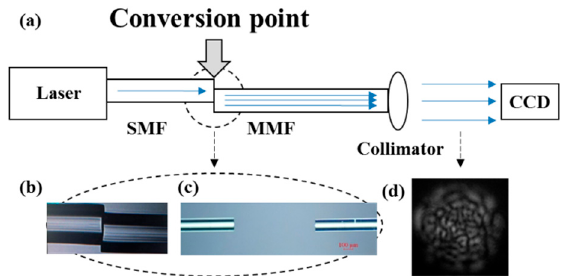
Figure 2. ( a ) Schematic diagram of the experimental setup of the fiber specklegram sensor; ( b ) Micrograph of the spliced specimen with a core offset r d , where z d is zero; ( c ) Micrograph of the aligned specimen with a core offset r d , where z d is nonzero; ( d ) The output specklegram detected by a charge-coupled device (CCD).